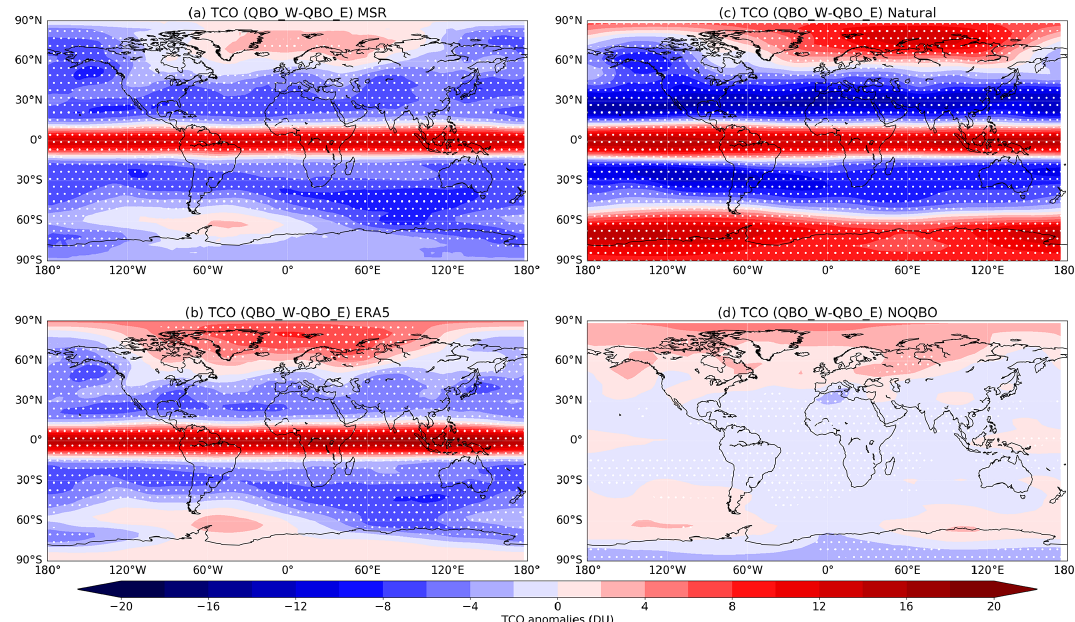
Figure 2. Influences of QBO (QBOW–QBOE) on global total column ozone (TCO) based on monthly anomalies from different data sets. (a) MSR2 data 1979–2020. (b) ERA5 data 1979–2020. (c) CESM-WACCM natural run 1979–2020. (d) CESM-WACCM NOQBO run 1979–2020. Stippled areas indicate results that are statistically significant over the 95% level, using the two-tailed Student’s t test.